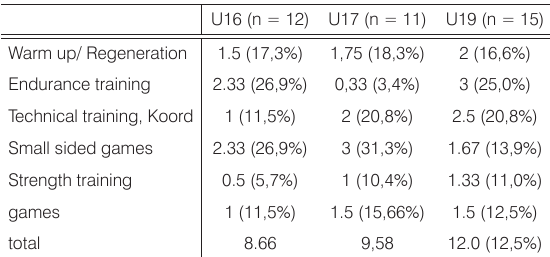
Table 3. Overview of average soccer training hours per week (hrs.(percentage) in the different age groups following